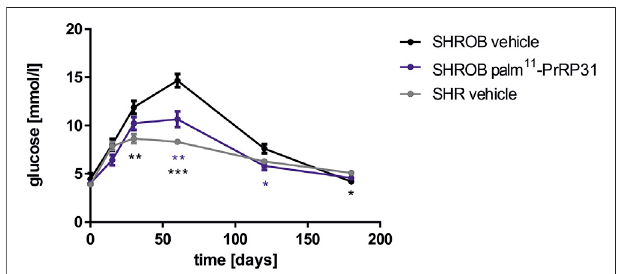
FIGURE 4 | Effect of chronic treatment with palm 11 -PrRP31 on glucose toleranceresponseinSHROBrats.Ratsweretreatedwithpalm 11 -PrRP31for 3 weeks (SHROB palm 11 -PrRP31 group). Oral glucose tolerance test (OGTT) was performed after overnight fasting at the end of experiment. Results are shown as a glucose pro fi le modi fi ed from (Mikulaskova et al., 2018). Data are presented as means ± S.E.M. Statistical analysis was performed by Two- way ANOVA with Tukey post hoc test, signi fi cance is p < 0.05, ** < 0.01, *** < 0.001 vs. the vehicle treated control SHR